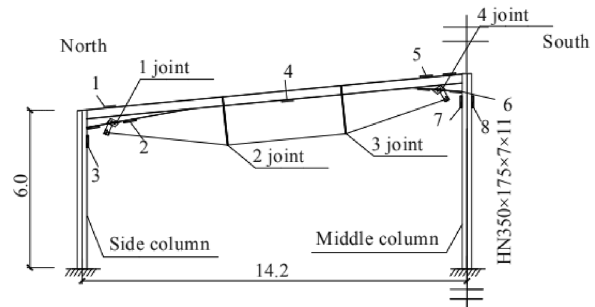
Fig. 18 Diagram of strain gauge sticking position: 1. 1 joint north (upper flange), 2. 1 joint south (lower flange), 3. Side column (south flange), 4. Middle span (lower flange), 5. 4 joint north (upper flange), 6. 4 joint south (lower flange), 7. Middle column (north flange), 8. Middle column (south